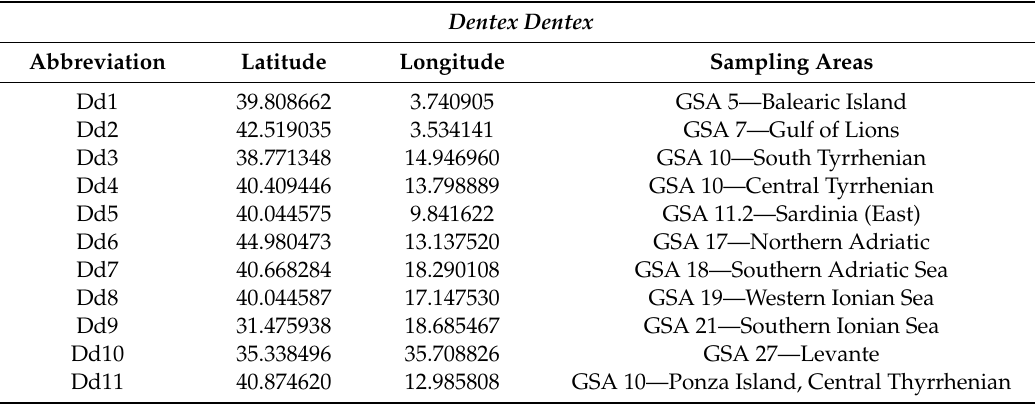
Table 3. Geographical origins of the D. dentex specimens sampled for this